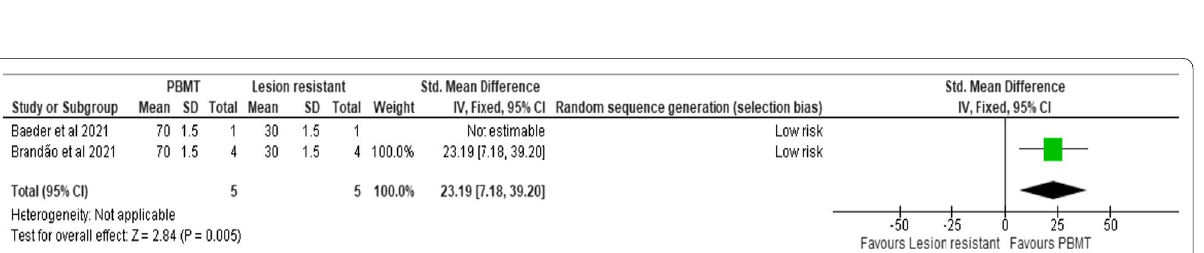
Fig. 3 Forest plot demonstrating meta-analysis for oral manifestations for COVID-19 patients facing PBMT